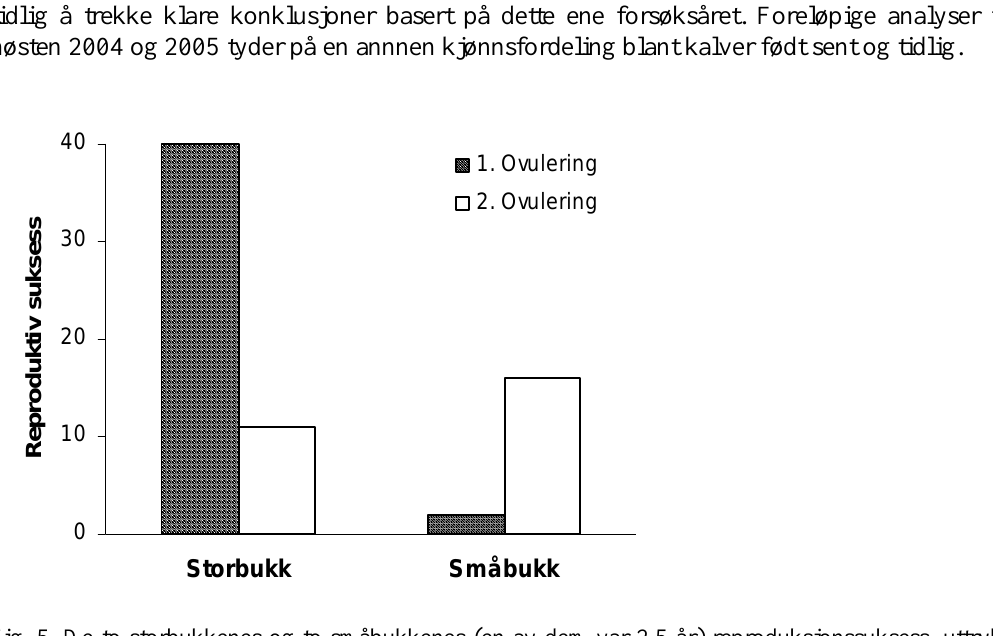
Fig. 5. De to storbukkenes og to småbukkenes (en av dem var 2,5 år) reproduksjonssuksess, uttrykt som antall kalver de er fedre til, i første og andre ovulering i 2003 (Røed et al ., upubl.). Reindriftas